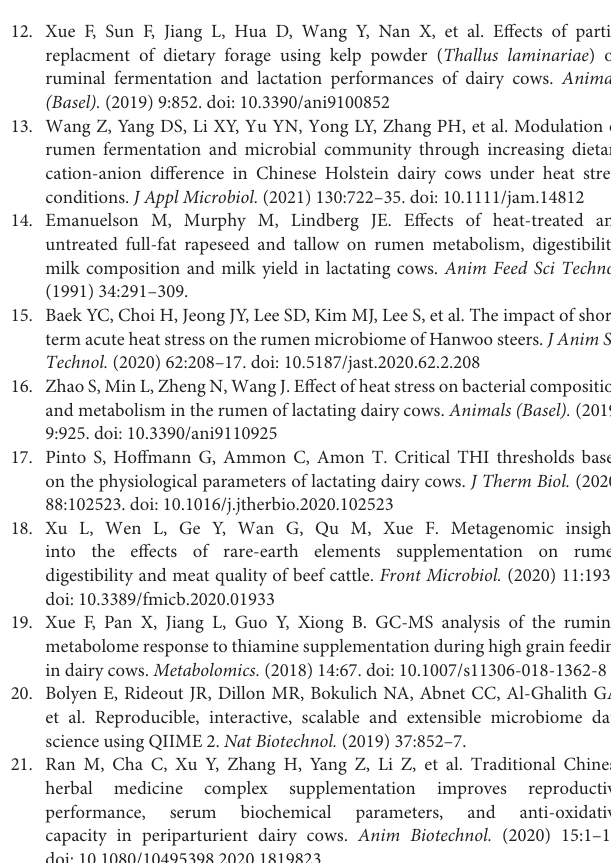
Supplementary Table 1 | Taxonomy results of ruminal bacteria